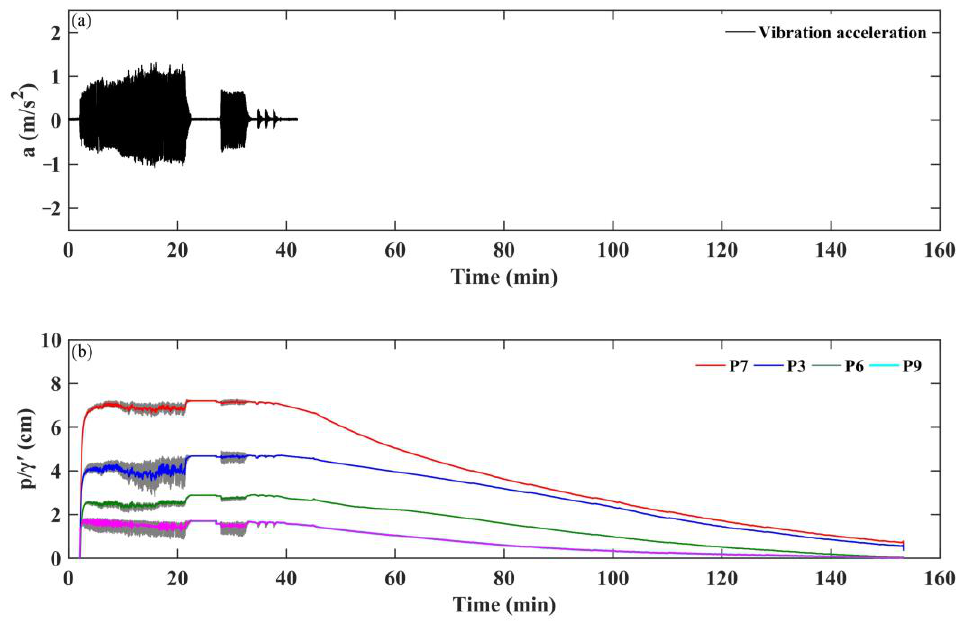
Figure 10. Time series of vibration acceleration ( a ) and excess pore pressure ( b ) in Test 14.